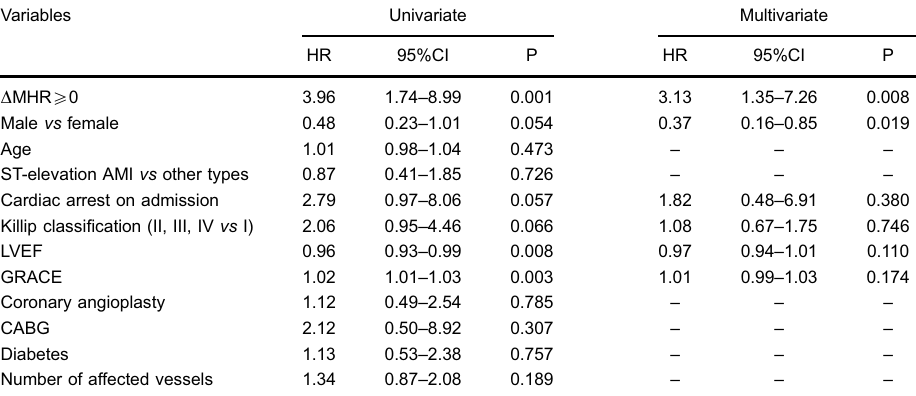
Table 3. Univariate and multivariate analysis for major adverse cardiovascular event predictors.